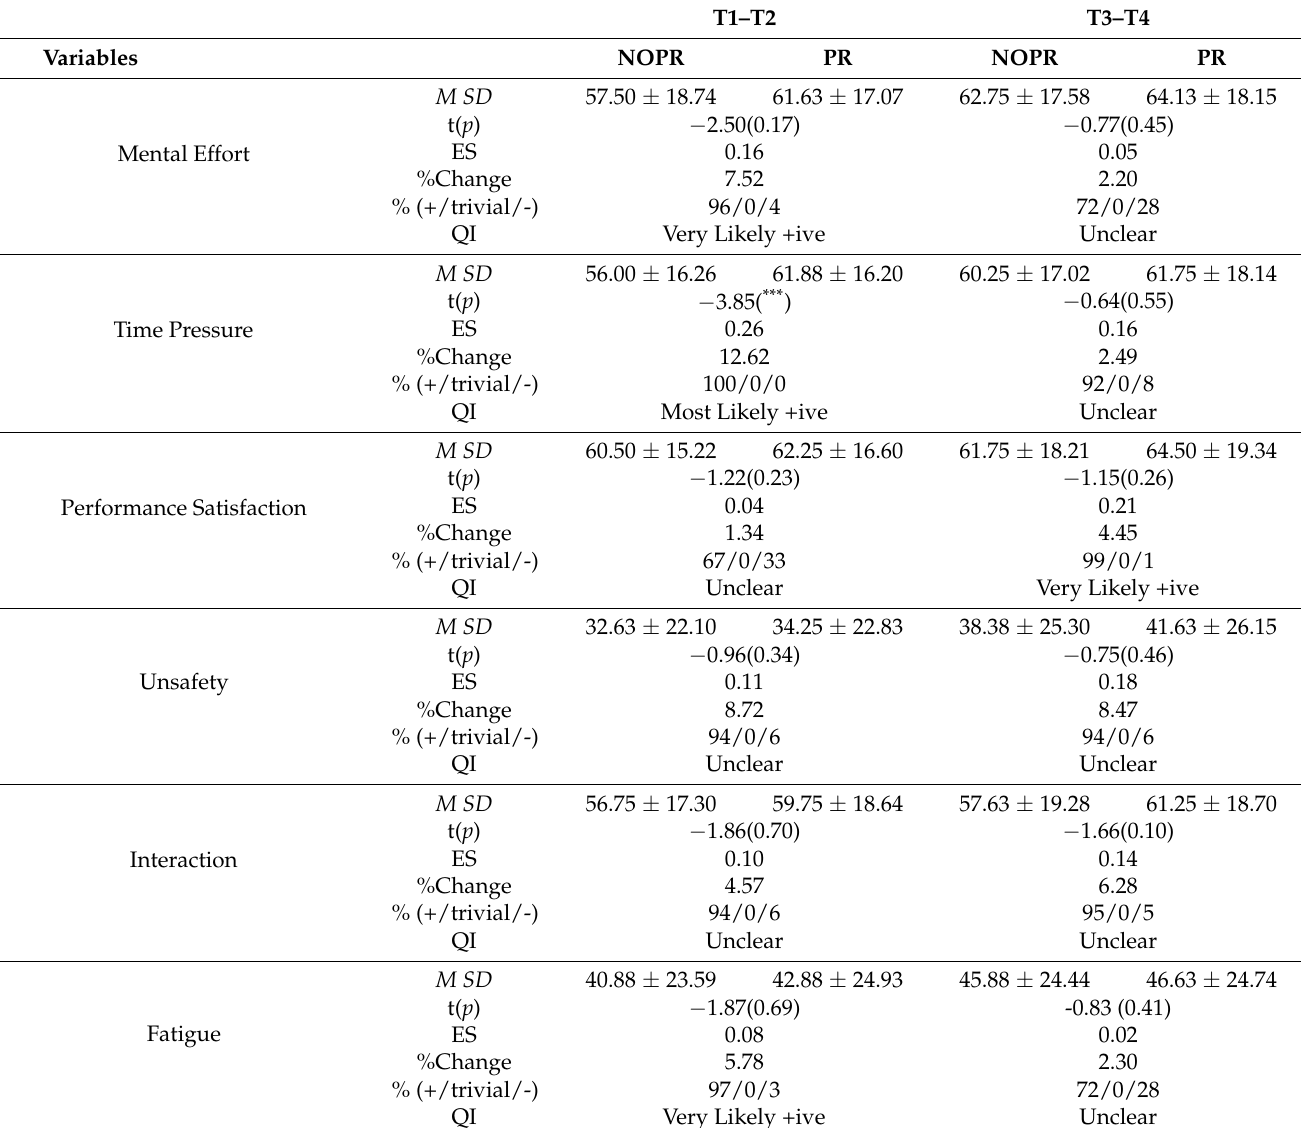
Table 4. Mental load and mental fatigue results between pairs of